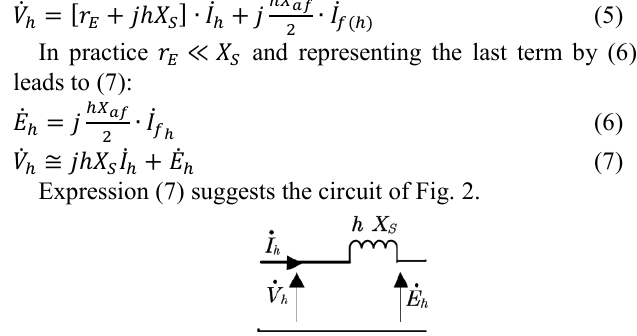
Fig. 2. Cylindrical rotor synchronous machine equivalent circuit.